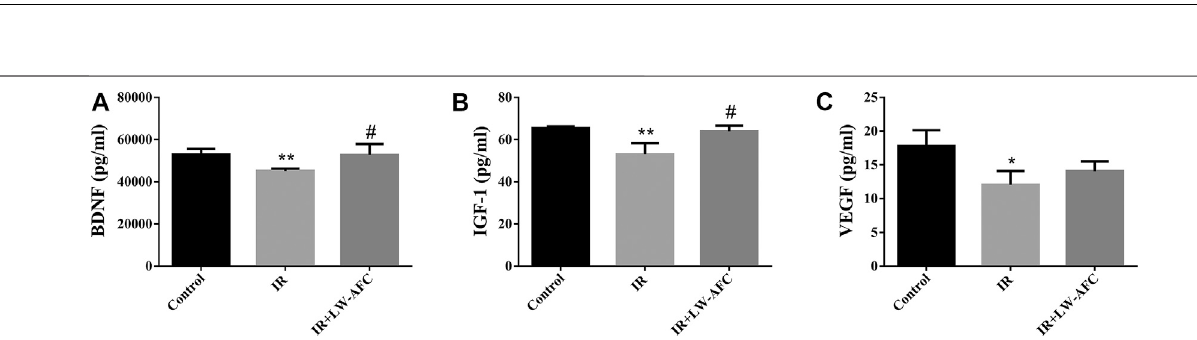
FIGURE 7 | LW-AFC increases the level of neurotrophic and growth factors in the hippocampus of IR mice on day 1 after irradiation. Concentrations of (A) BDNF, (B) IGF-1, and (C) VEGF were detected. The values denote mean ± S.D., n (cid:2) 4. * p < 0.05 and ** p < 0.01, versus the control group. # p < 0.05, versus the IR group. Abbreviation: IR,